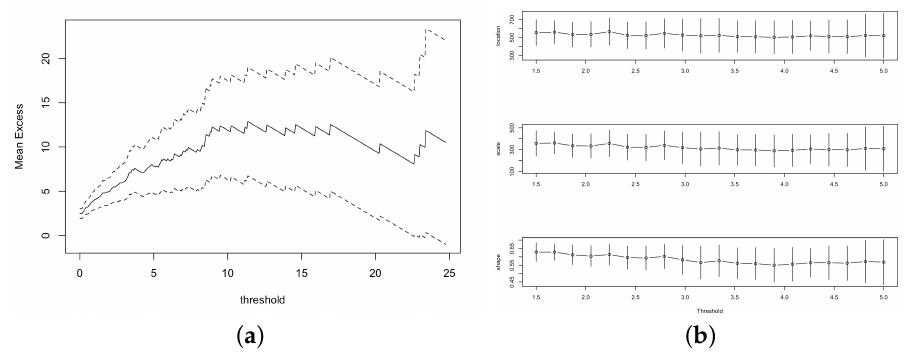
Figure 3. ( a ) Sample mean excess for economic loss in billion yuan with grey dash line representing 95% confidence interval. ( b ) Variation plots of location, scale, and shape (from top to bottom) against threshold u ∈ ( 1.5,5 )